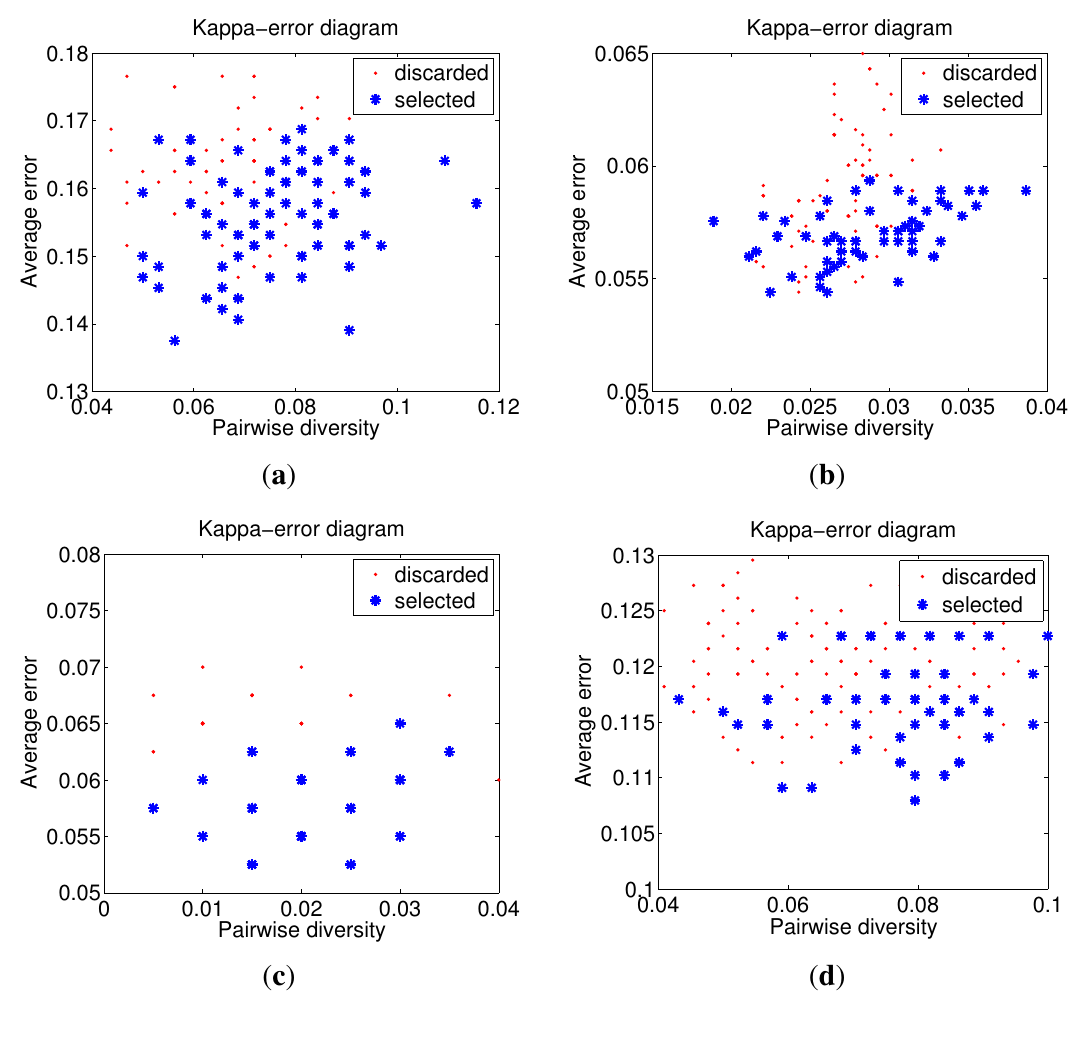
Figure 14. Kappa-error diagrams of four databases (red points denote the discarded base classifiers, blue stars represent the selected base classifiers): ( a ) ORL ( p = 2 ); ( b ) Yale2 ( p = 5 ); ( c ) AR (Subset B); ( d ) FERET-1 ( p = 2